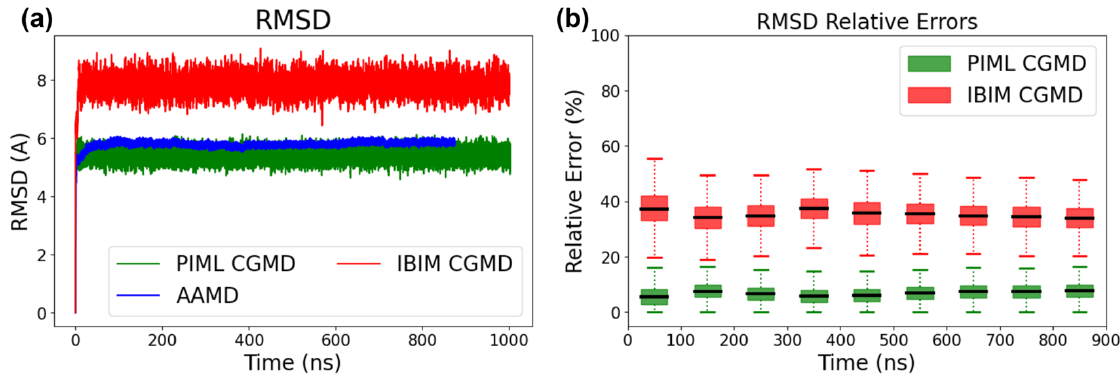
Figure 8. RMSD comparison between the proposed CGMD simulation and the AAMD validation simulation. RMSD in angstroms ( a ). RMSD relative errors ( b ).